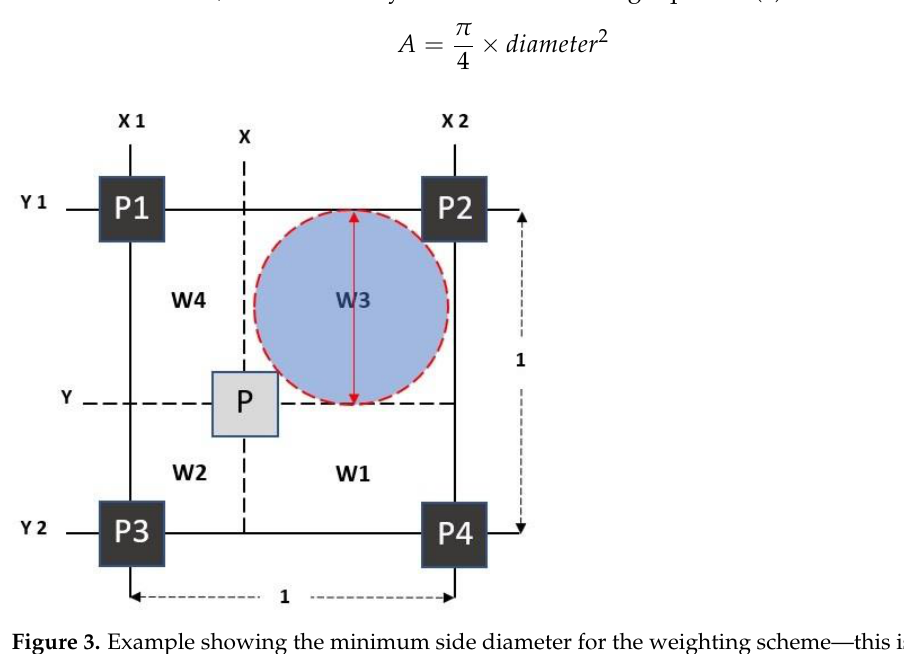
Figure 3. Example showing the minimum side diameter for the weighting scheme—this is the MD weighting